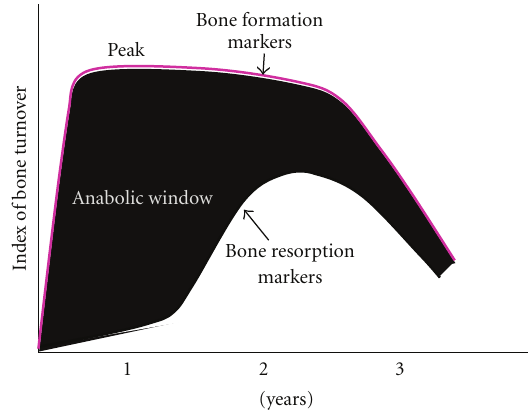
Figure 4: The anabolic window. The figure demonstrates the concept that bone formation is first stimulated by teriparatide or PTH(1-84) followed by an increase in bone resorption (adapted from